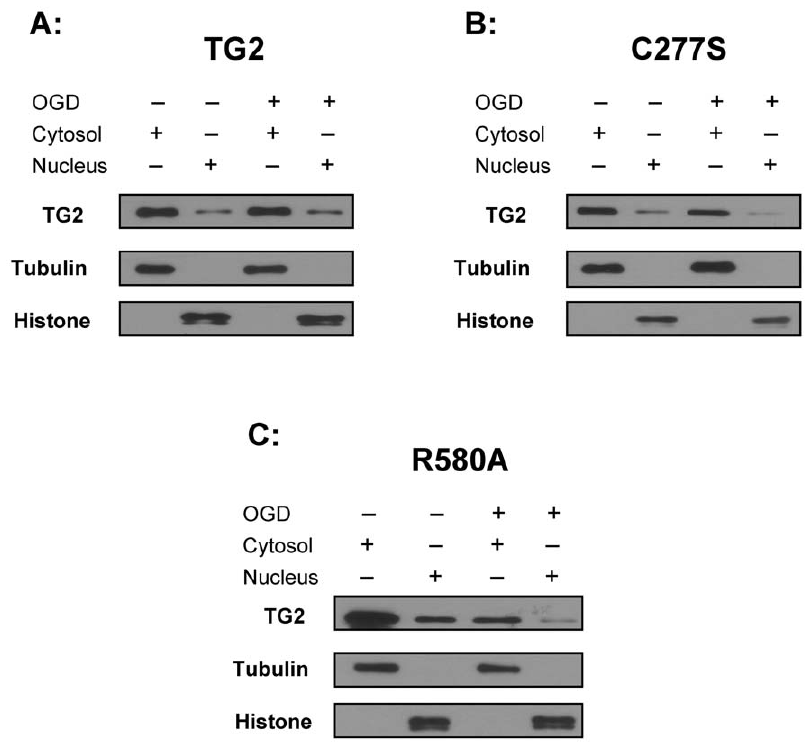
Figure 3. Subcellular localization of TG2, TG2-C277S and TG2-R580A. A , B , C , Immunoblots showing subcellular localization of TG2, TG2- C277S (C277S) and TG2-R580A (R580A). Striatal stable cells were fractionated into nuclear and cytosolic compartments with or without OGD treatment. Cell lysates were blotted for TG2 (1 st panels), histones (2 nd panels), tubulin (3 rd panels). Histone and tubulin blots show the purity of the fractions. TG2 blots show that there is no increase in the nuclear TG2 levels after OGD treatment in any of the cell